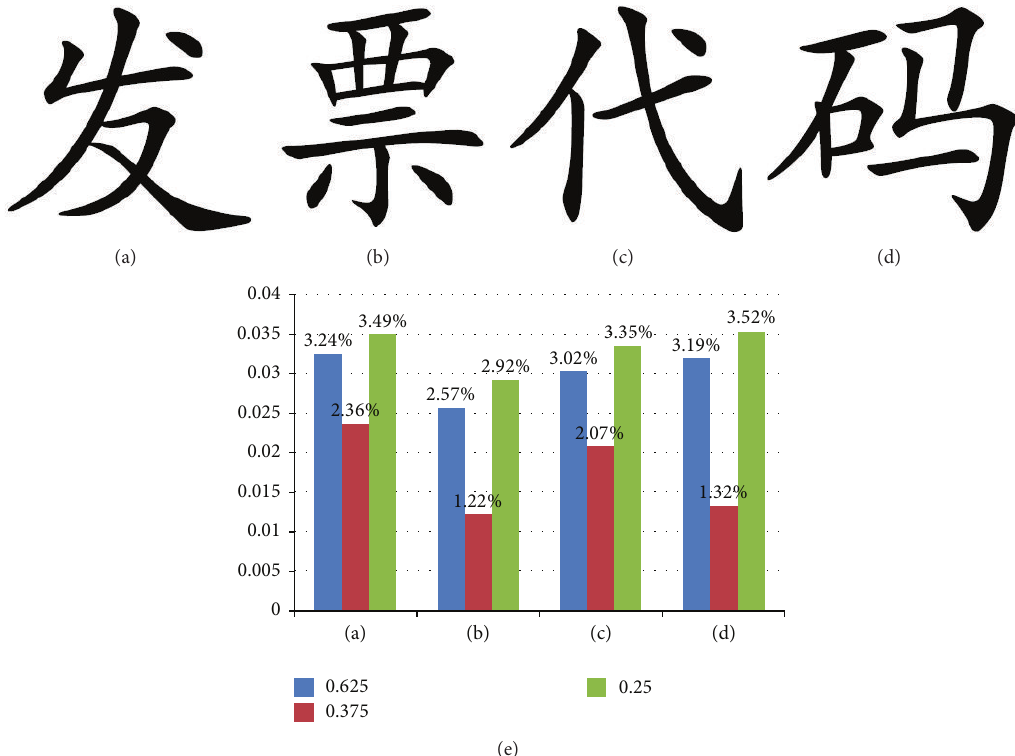
Figure 7: The summary of score ratio in four most-commonly used font binary images in invoice. In (e), the horizontal axis denotes the different font binary image and the vertical axis is the ratio in total pixels of this font binary image.